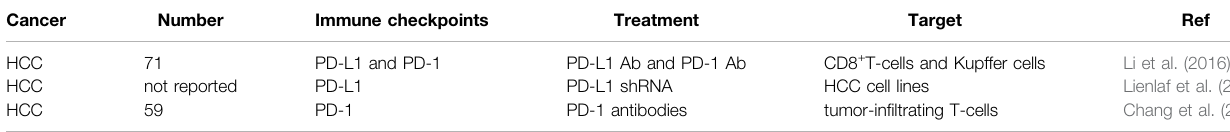
TABLE 3 | Pre-clinical studies with PD-1 immune checkpoints.